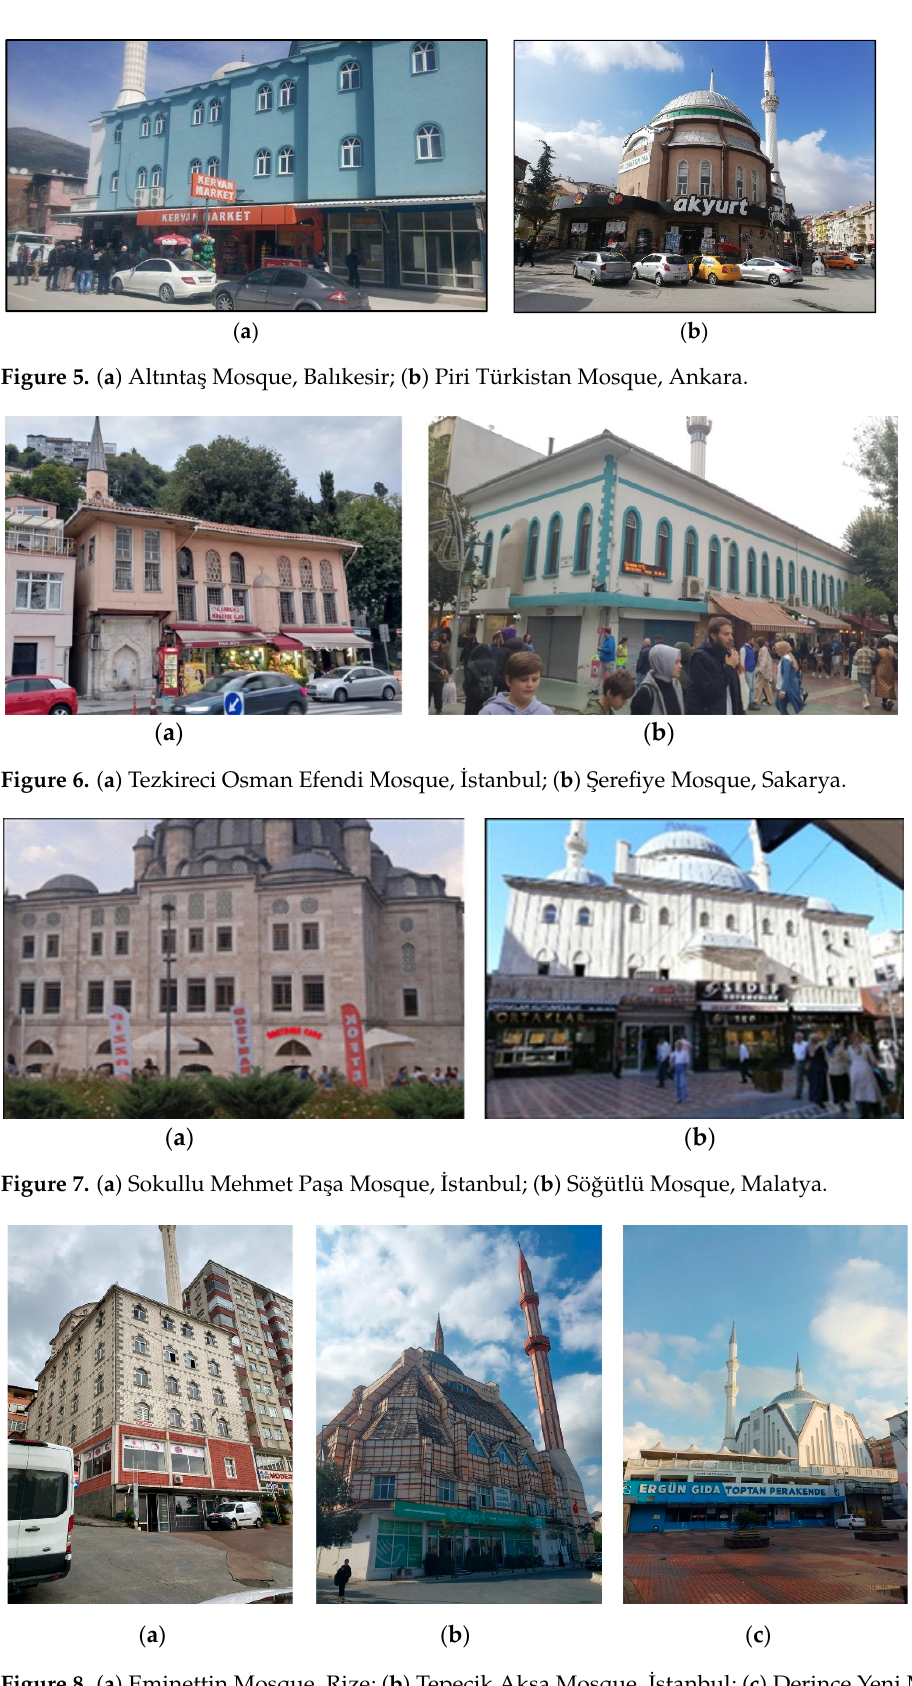
Figure 8. ( a ) Eminettin Mosque, Rize; ( b ) Tepecik Aksa Mosque, İ stanbul; ( c ) Derince Yeni Merkez Mosque, Kocaeli. Mosque,